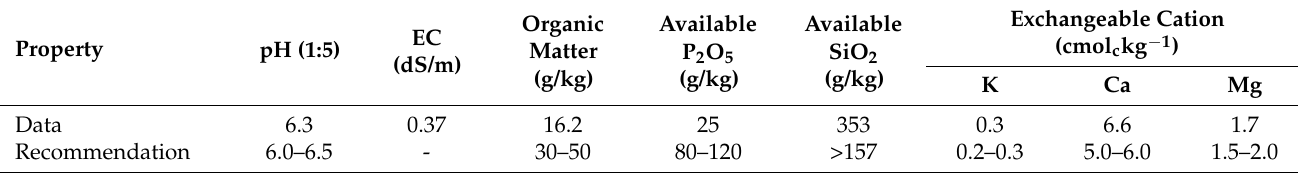
Table 1. Soil chemical properties of the rice research field used in this